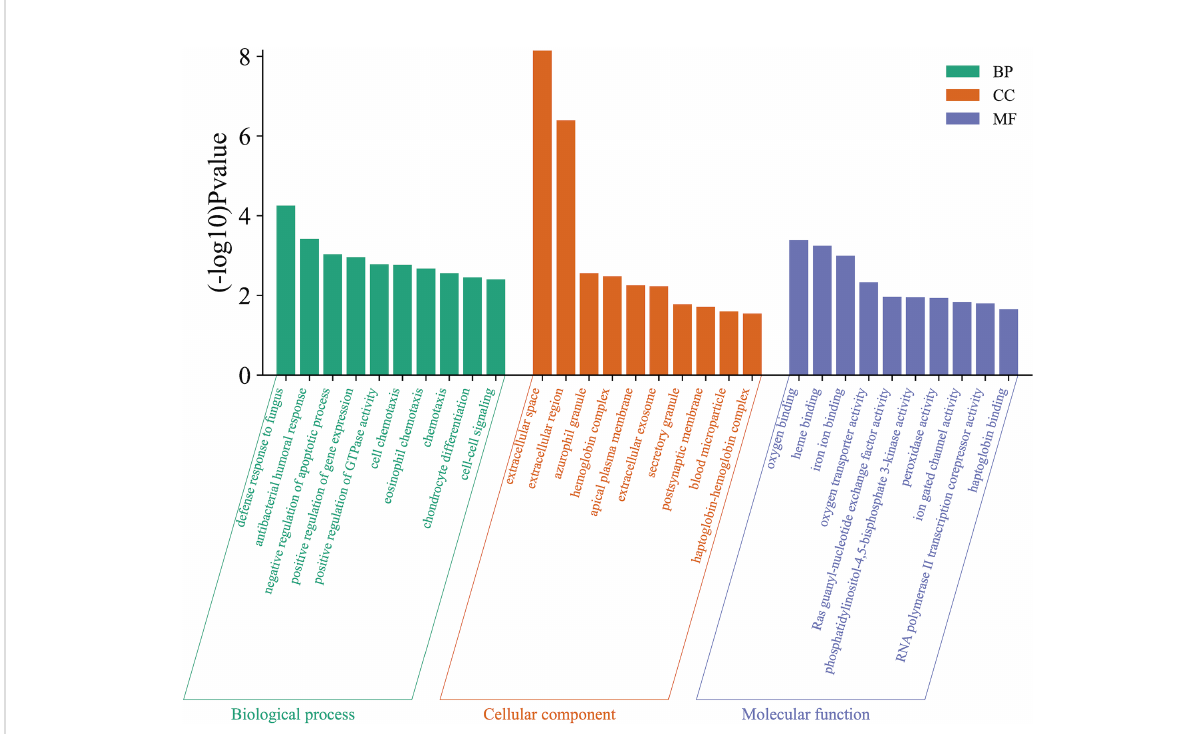
FIGURE 7 GO functional enrichment analysis (n=3). The fi gure shows the top 10 related enrichment pathways of each GO functional